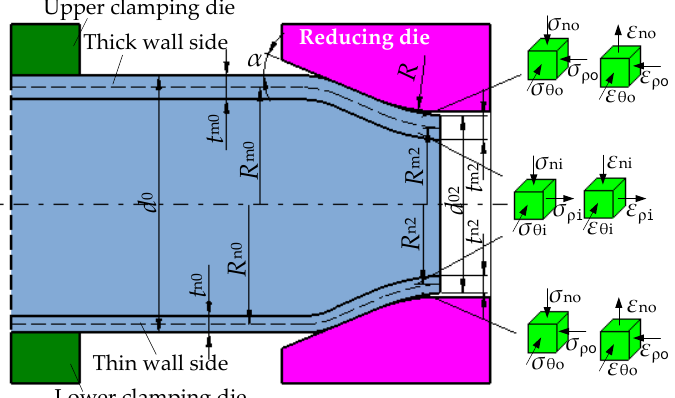
Figure 7. Bending stage.